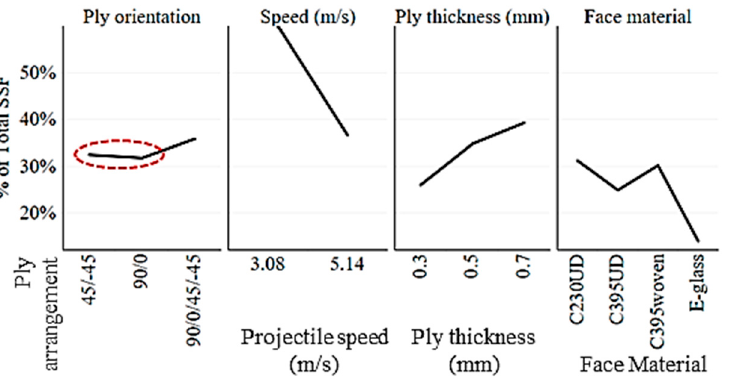
Figure 11. Parametric trends for conventional composite. Red ellipse indicates insignificant range.